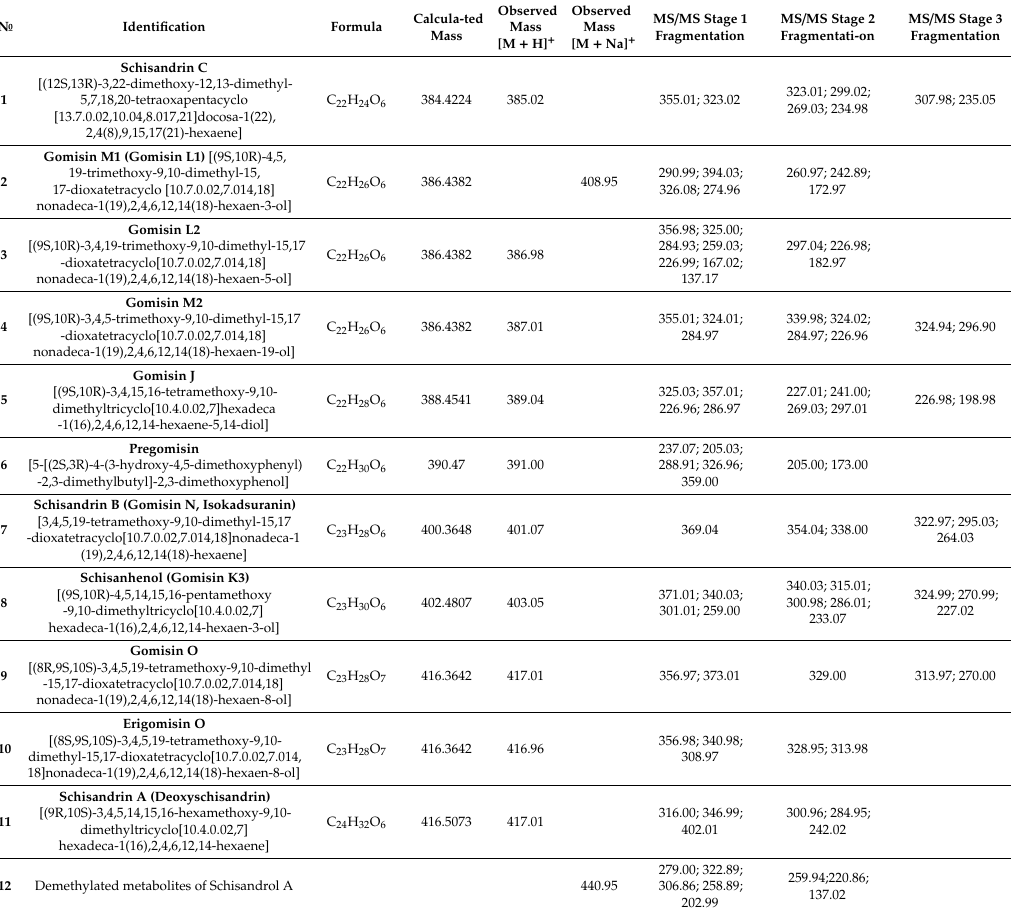
Table 2. Lignans from S. chinensis SC-CO 2